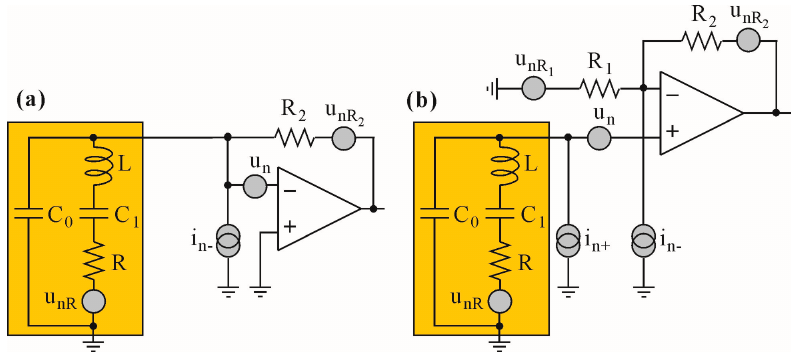
Figure 7. Noise sources of the analyzed configurations of the preamplifier: ( a ) transimpedance configuration; ( b ) voltage configuration.